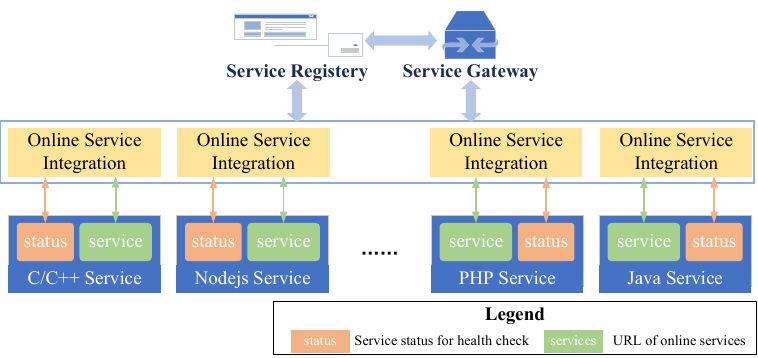
Figure 9. Sidecar model of the platform. Each service can be accessed after passing the health status check.